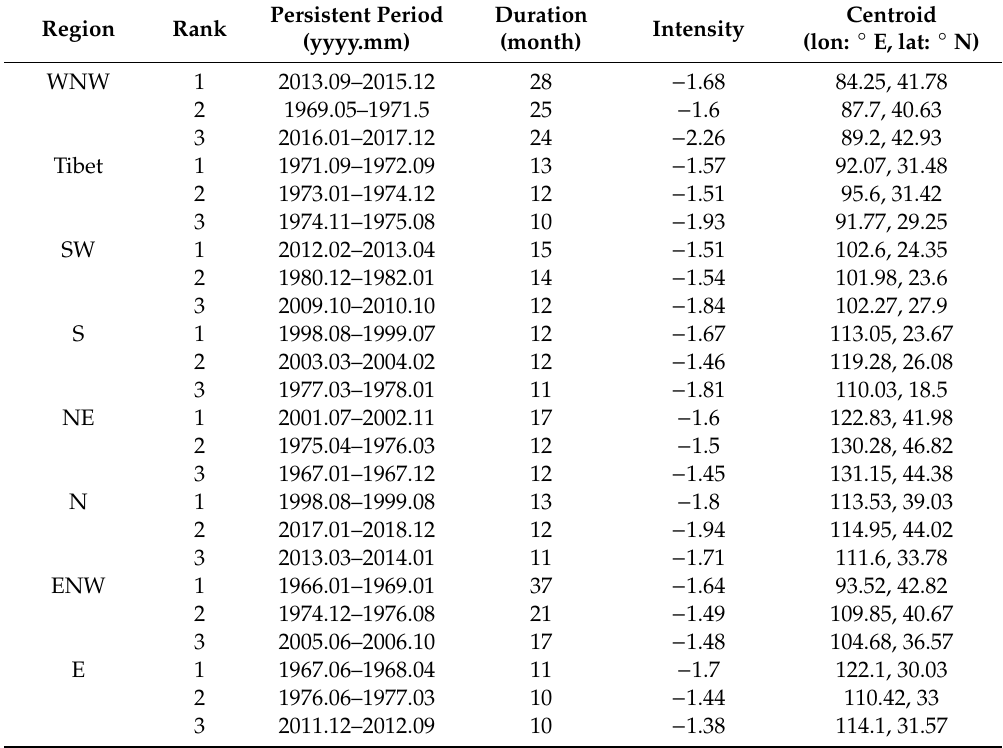
Table 3. Major drought (top 3) events ranked by duration for each subregion in the past 53 years. Region